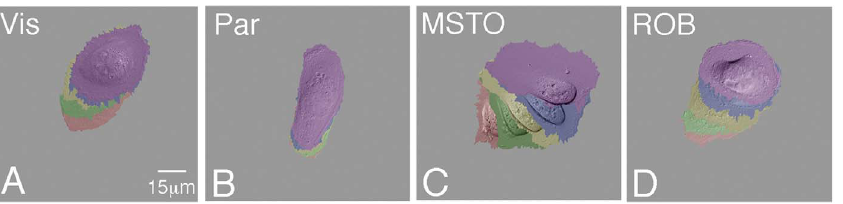
Figure 5. Mesothelia have varying abilities to migrate. Visceral mesothelial (A), parietal mesothelial (B), pleural mesothelioma (C), and peritoneal mesothelioma (D) cells were plated on fibronectin and subjected to time-lapse imaging in order to visualize their ability to migrate. Panels A–D are compilations of static images taken at 20 minute intervals. False coloration indicates a cell’s location at each interval: red 0 min; green 20 min; yellow 40 min; blue 60 min; purple 80